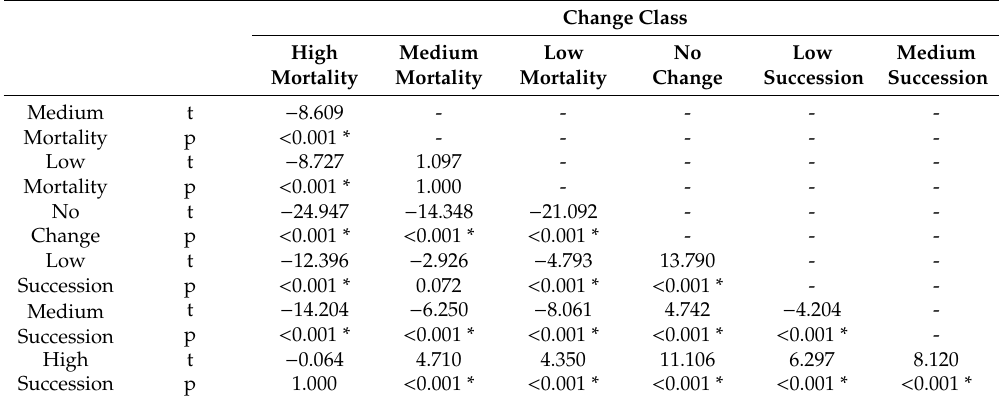
Table 4. Results of slope t-test between change classes. Significant values in bold. Significant di ff erences were seen in 18 out of 21 tests.